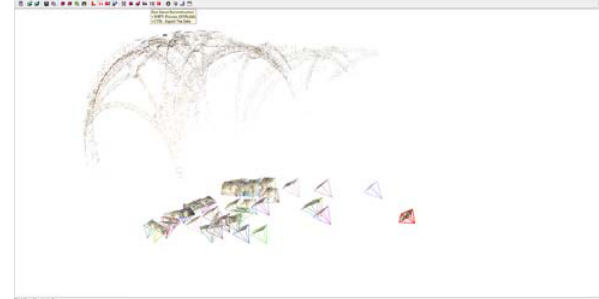
Figure 5: location of photographs in Visual SfM